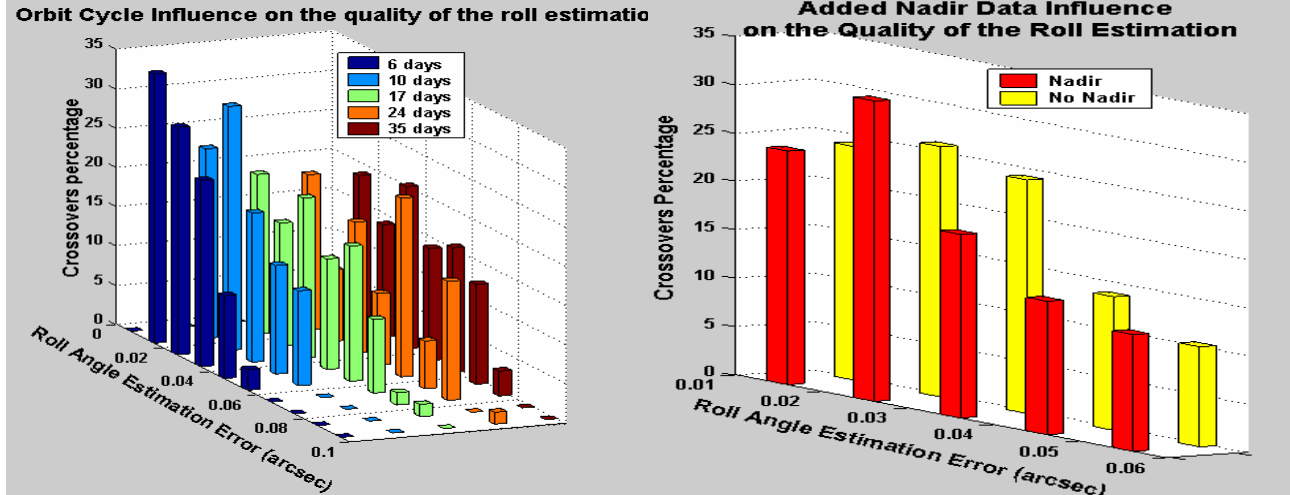
Figure 17. (a) Influence of the orbit characteristics on the quality of the processing (b) Influence of the presence of nadir altimeter on the quality of the